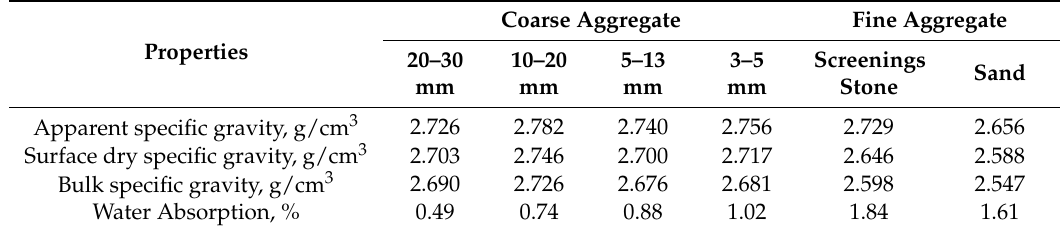
Table 1. Properties of coarse and fine aggregate.